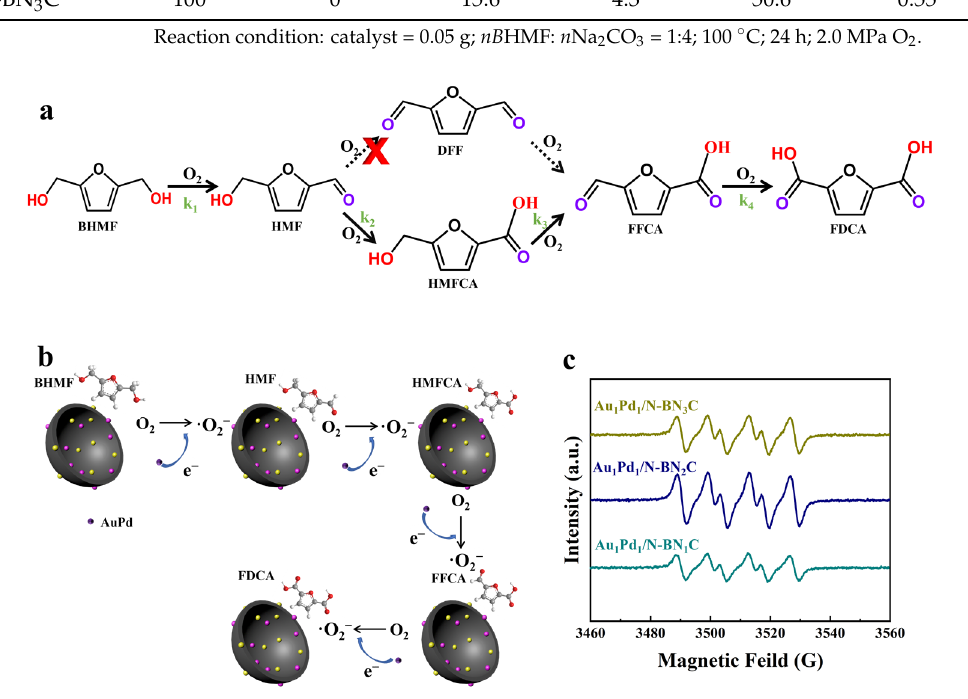
Figure 8. Reaction path of BHMF-catalyzed oxidation to FDCA ( a ), the mechanism of catalytic oxidation of BHMF to FDCA over Au m Pd n /N-BN x C nanocatalysts ( b ), and ESR spectra (superoxide radicals) of Au 1 Pd 1 /N-BN x C ( c ) (x = 1, 2, 3, corresponding to MBA:AM = 1:1, 1:2, 1:3, respectively).